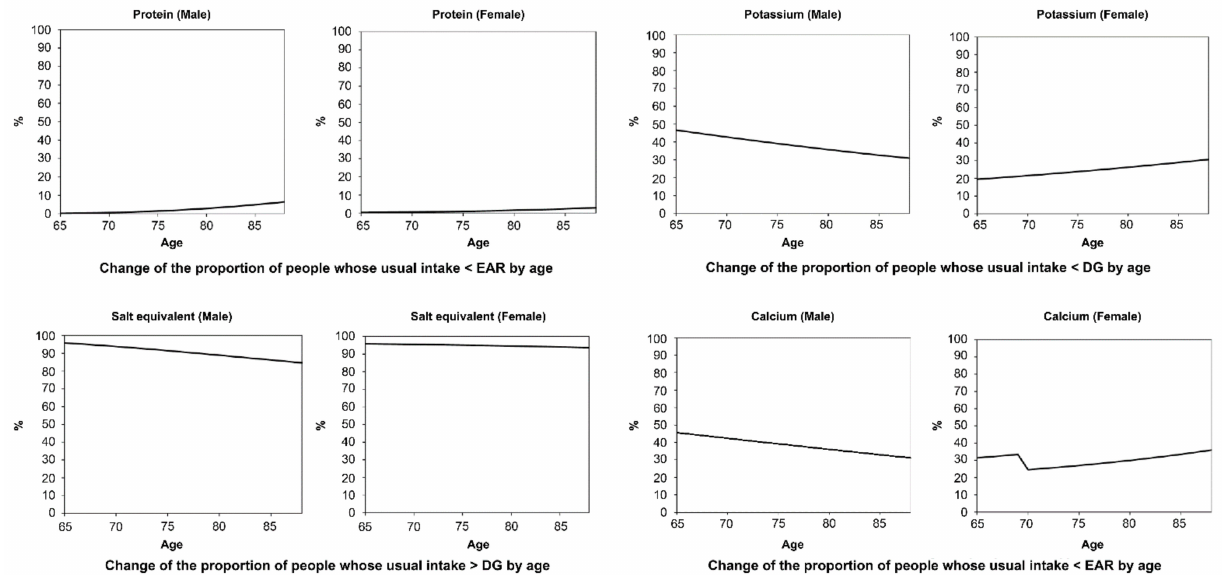
Figure 5. The proportion of individuals whose usual intake was under the estimated average requirement (EAR) or dietary goal (DG) in protein, salt equivalent, potassium and calcium (male and